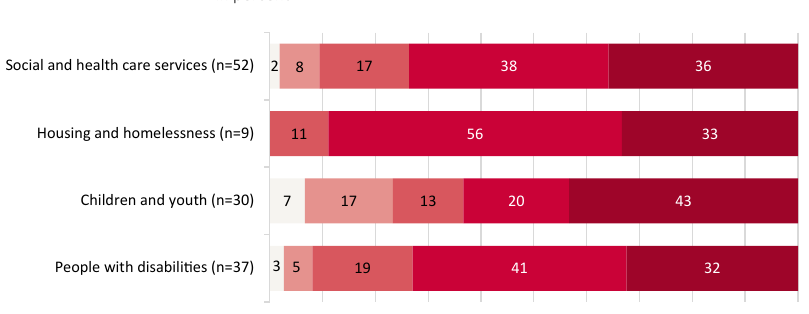
Figure 1: Degree of affectedness of CSOs in different fields of social services, in percent. (Source: Millner et al. 2020,